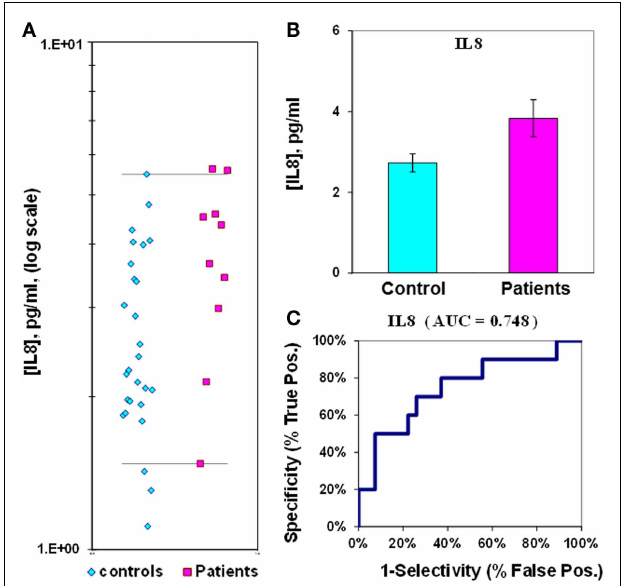
FIGURE 4 |Assay of IL-8 in plasma from epilepsy patients and controls. (A) Dot-plot of IL-8 concentrations in plasma (square, patients; diamond, controls). For values between the horizontal lines, the assay does not accurately discriminate between patients and controls. (B) Bar graph and error calculation for data in Part (A) . Difference is 1.4-fold, and significant for p = 0.020. (C) ROC curve for data in Part (A) , showing an area under the curve (AUC) value of 0.75.